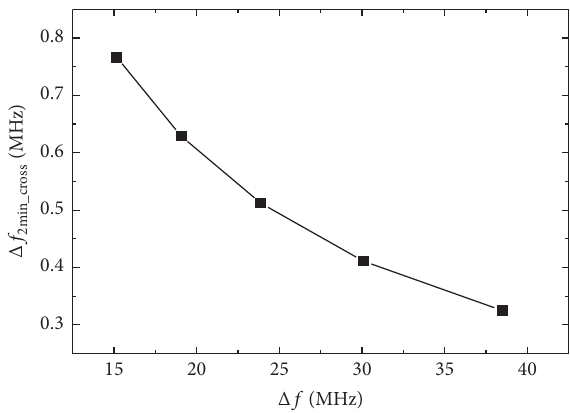
. Figure 12: The influence of Δ𝑓 on the value of Δ𝑓 2 min _ cross